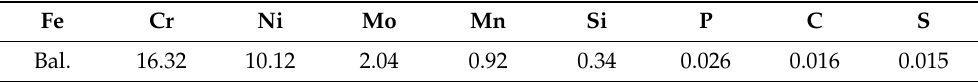
Table 2. Chemical composition of AISI 316L stainless steel substrate (wt.%).